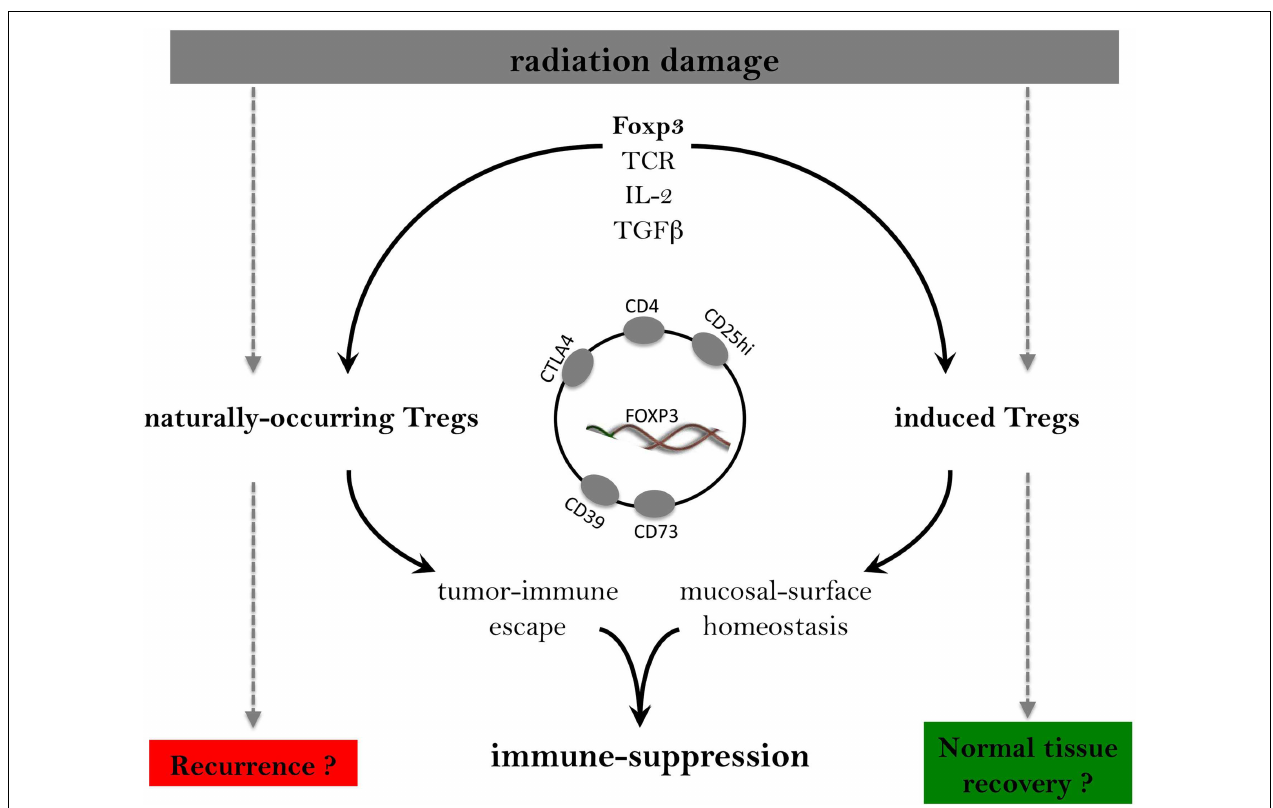
stimulation.While bothTreg subsets contribute to immune suppression, iTregs seem to be selectively involved in mucosal surfaces. Radiation therapy drives an increase inTregs that may limit potential anti-tumor immunity and aid tumor escape on one side but that may also nurture normal tissue recovery on the